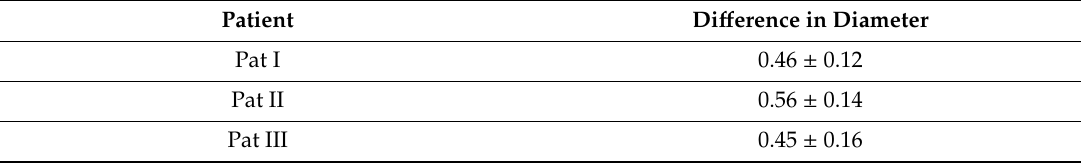
Table 5. Average di ff erence in diameter for Feret diameter included standard deviation ( ± SD).